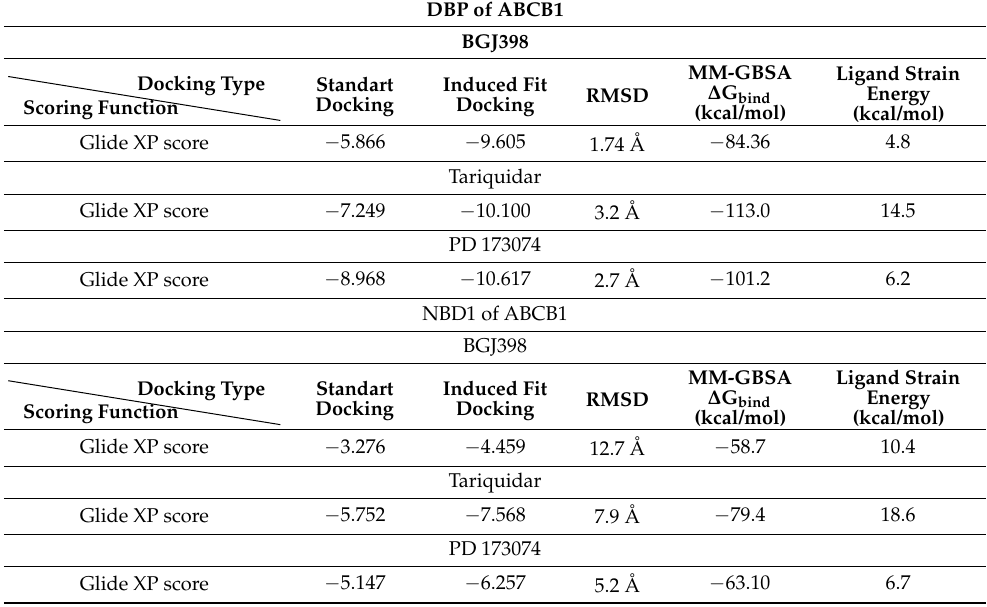
Table 3. Docking score (SP and XP Modes), MM-GBSA ∆ Gbind prime energy, Ligand strain energy, RMSD of BGJ 398, Tariqiudar and PD 173074 with DBP and NBD1 of ABCB1. DBP of ABCB1